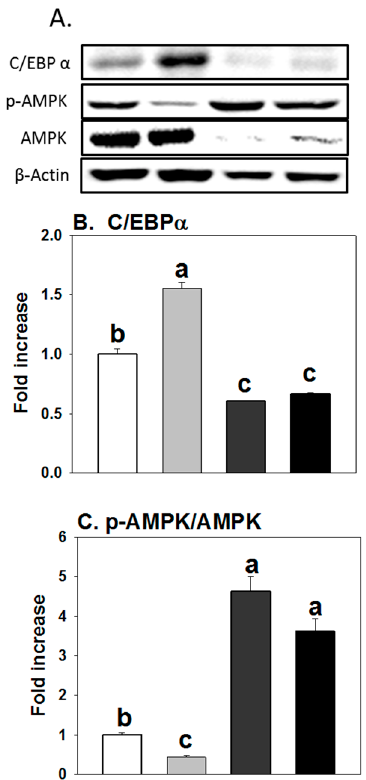
Figure 4. AICAR (5-Aminoimidazole-4-carboxamide ribonucleotide) abolished the increased expression of C/EBP α while flubendiamide induced the decreased expression of pAMPK α . A: representative picture; B: C/EBP- α , CAATT element binding protein- α ; C: pAMPK α /AMPK α . Cells were treated with flubendiamide (10 μ M) or AICAR (40 μ M) for 8 days. Each value is expressed as the mean ± standard error of three separate experiments. Means with different letters were significantly different at p < 0.05 (a vs. b, a vs. c or b vs. c are significantly different).